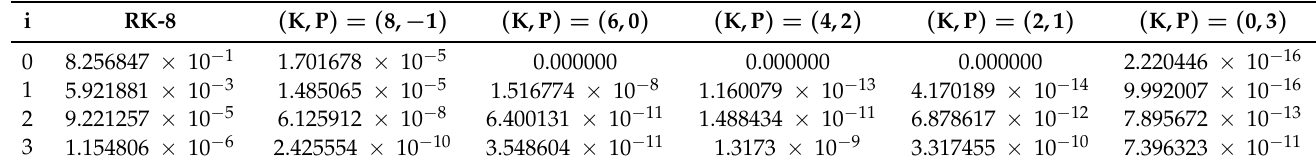
Maximum absolute error for constructed methods on Section 5.1 with step-size h = 2 − i π , i =